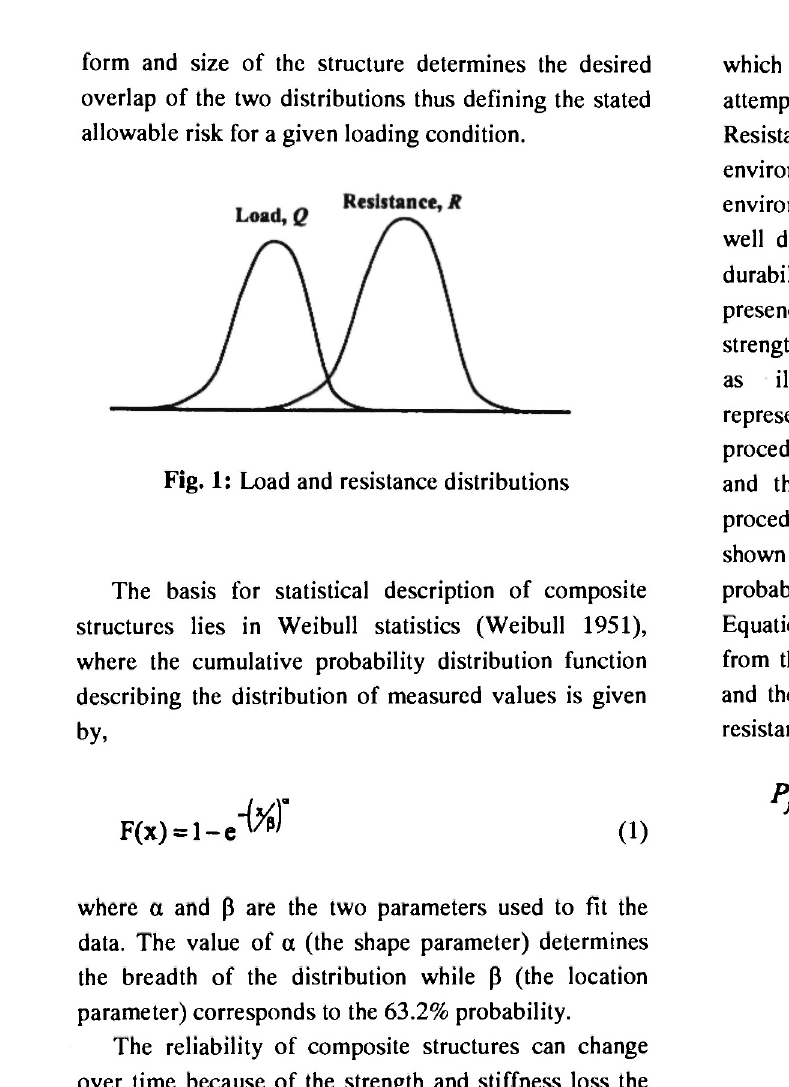
Fig. 2: The hypothesized changes in the probability density function describing the statistical distribution in the resistance (strength) of a component or